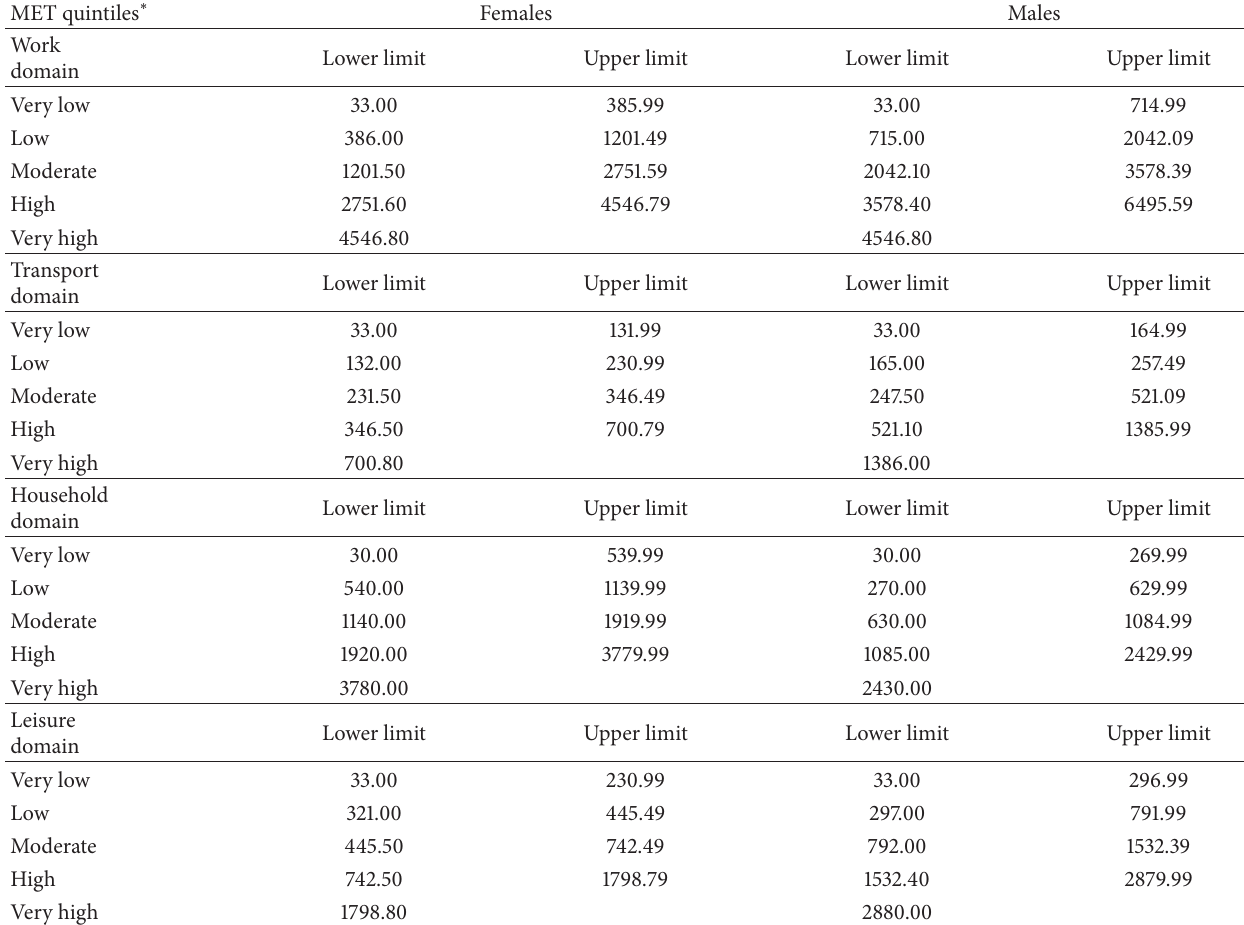
Table 1: Gender-specific MET quintiles for each domain of physical activity (Maracaibo, Venezuela,